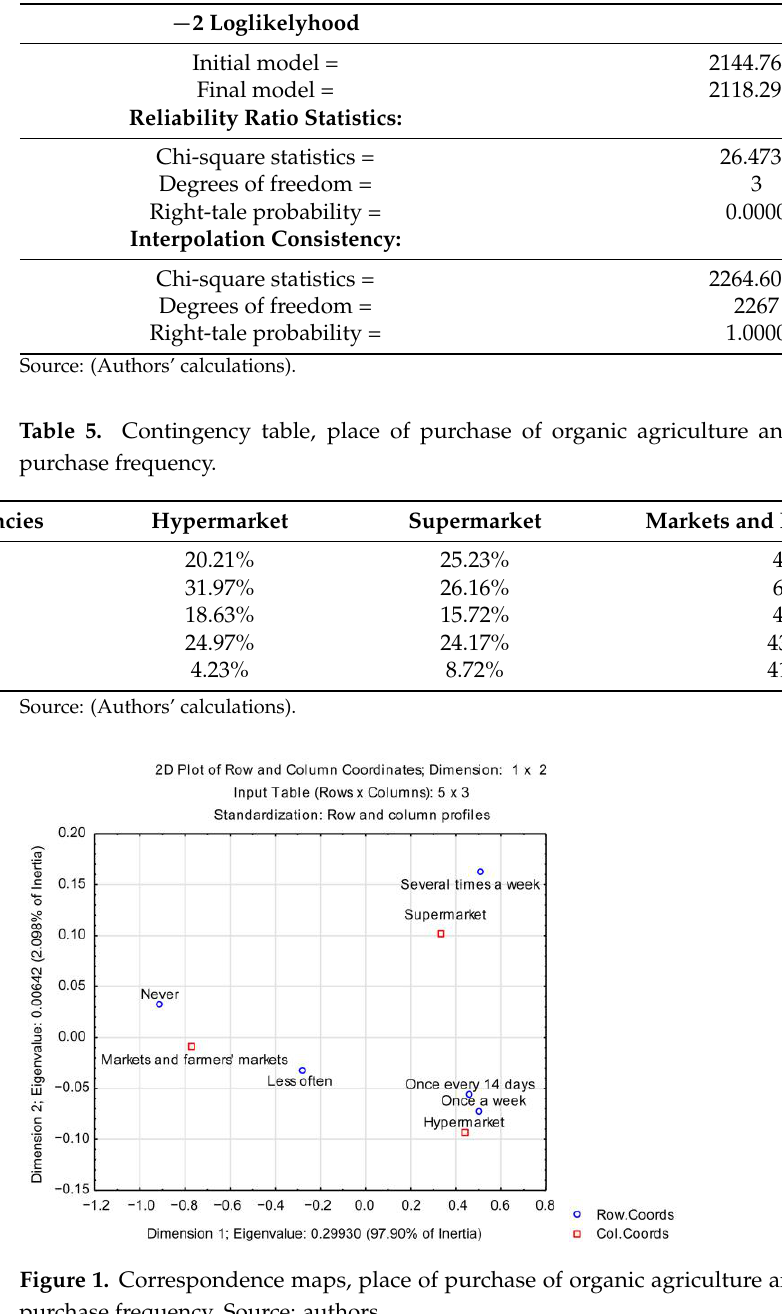
Table 4. Statistical significance of the model.